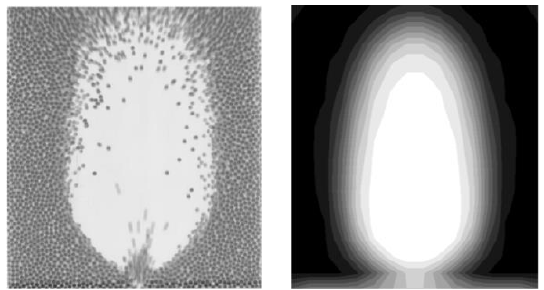
Figure 2. Experimental ( left ) and predicted ( right ) particle distribution at 150 mm.